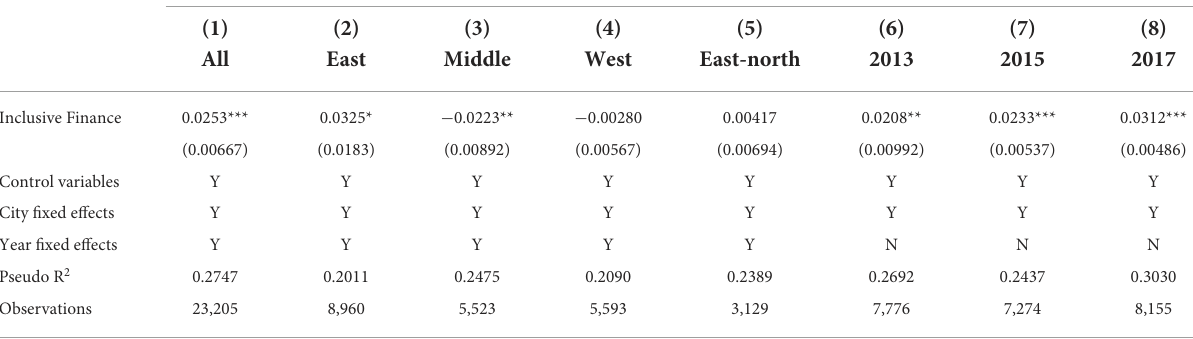
TABLE 3 Heterogeneity regression results for financial inclusion on